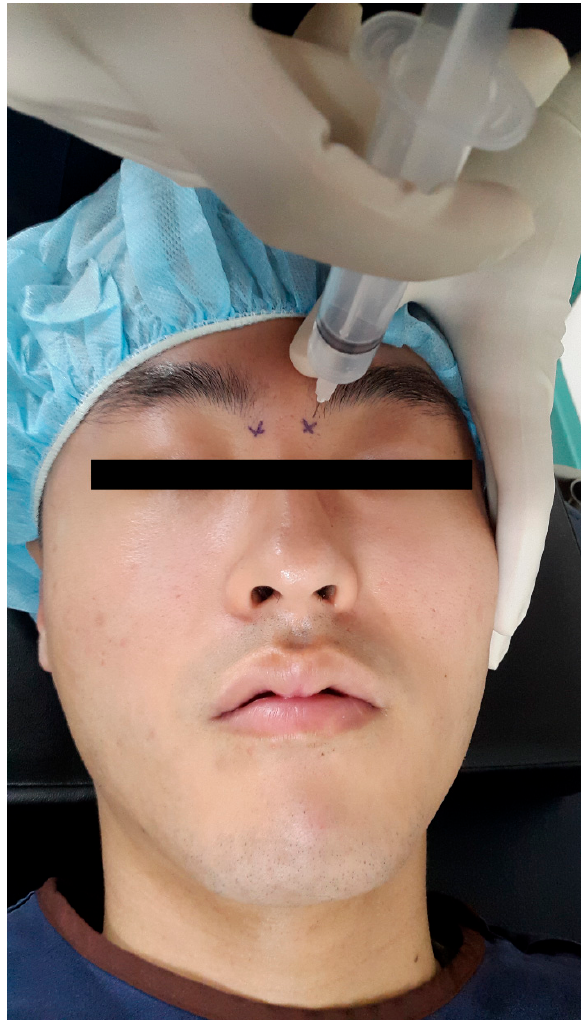
Figure 2. Infratrochlear nerve block.